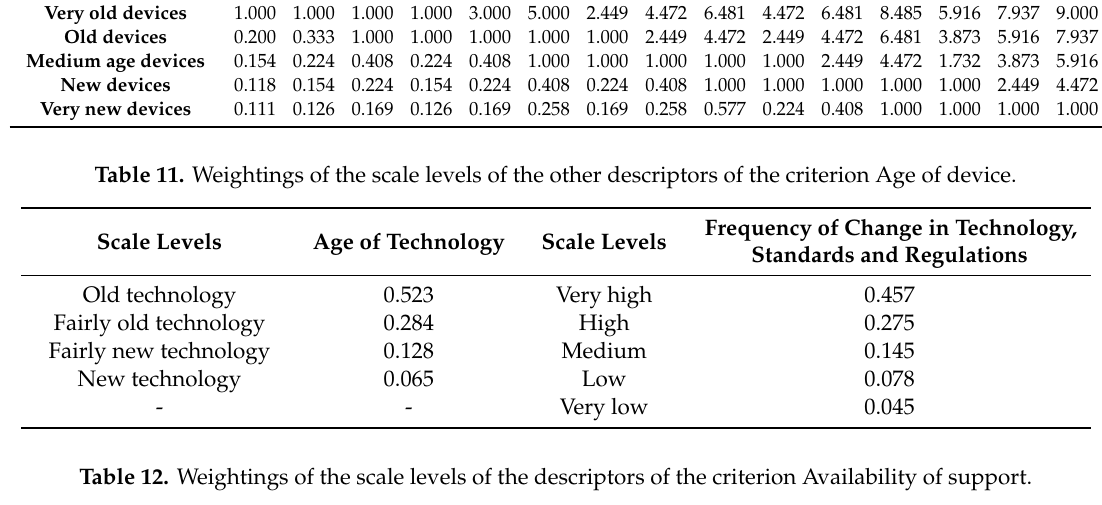
Table 9. Combined judgement matrix using geometric means for the subcriteria of the criterion Costs. COS1 COS2 l ij m ij